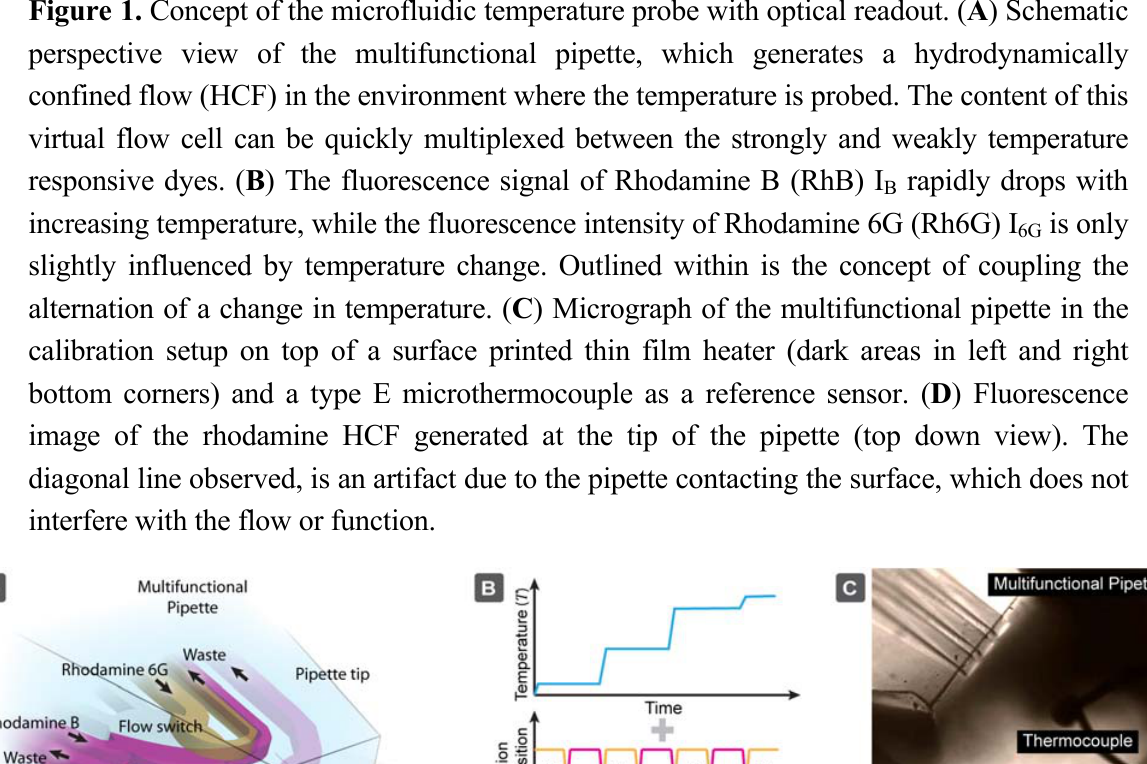
rapidly drops with B is only 6G